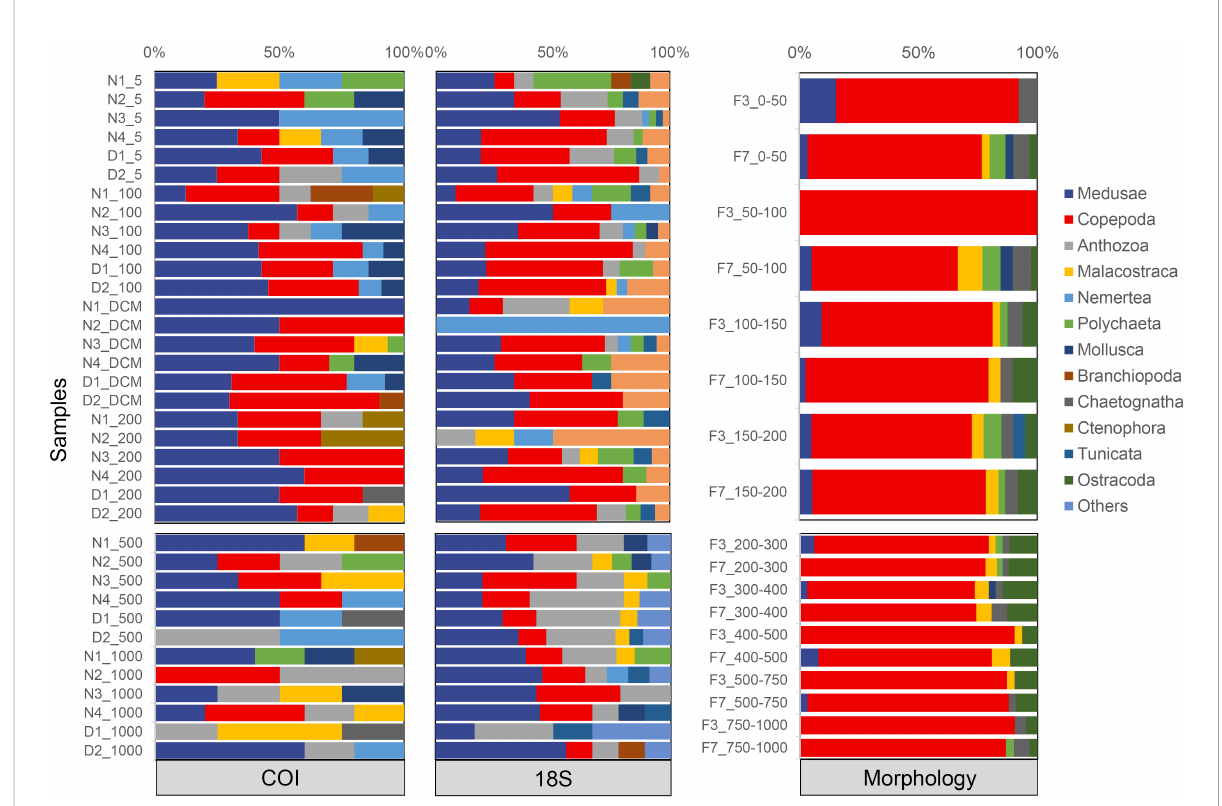
TABLE 2 Numbers of unique taxa, ASVs, and reads for metabarcoding, and numbers of unique taxa categories and abundance (ind./m 3 ) for morphology across mesozooplankton groups. Mesozooplankton COI 18S Morphology group